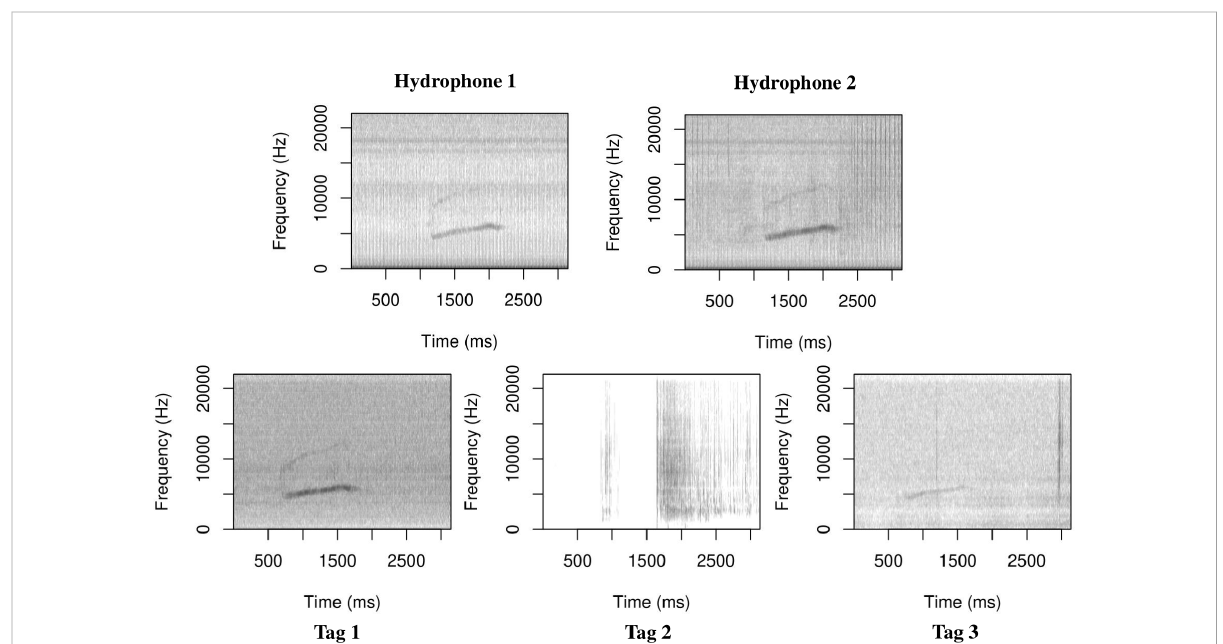
FIGURE 4 Hydrophone spectrograms (above) and tag spectrograms (below) show that a given whistle was recorded with a clear gradient of acoustic intensity. Qualitative comparisons were useful to formulate predictions concerning a caller ’ s identity. In the case presented here, the individual equipped with Tag 1 was the best candidate to be the